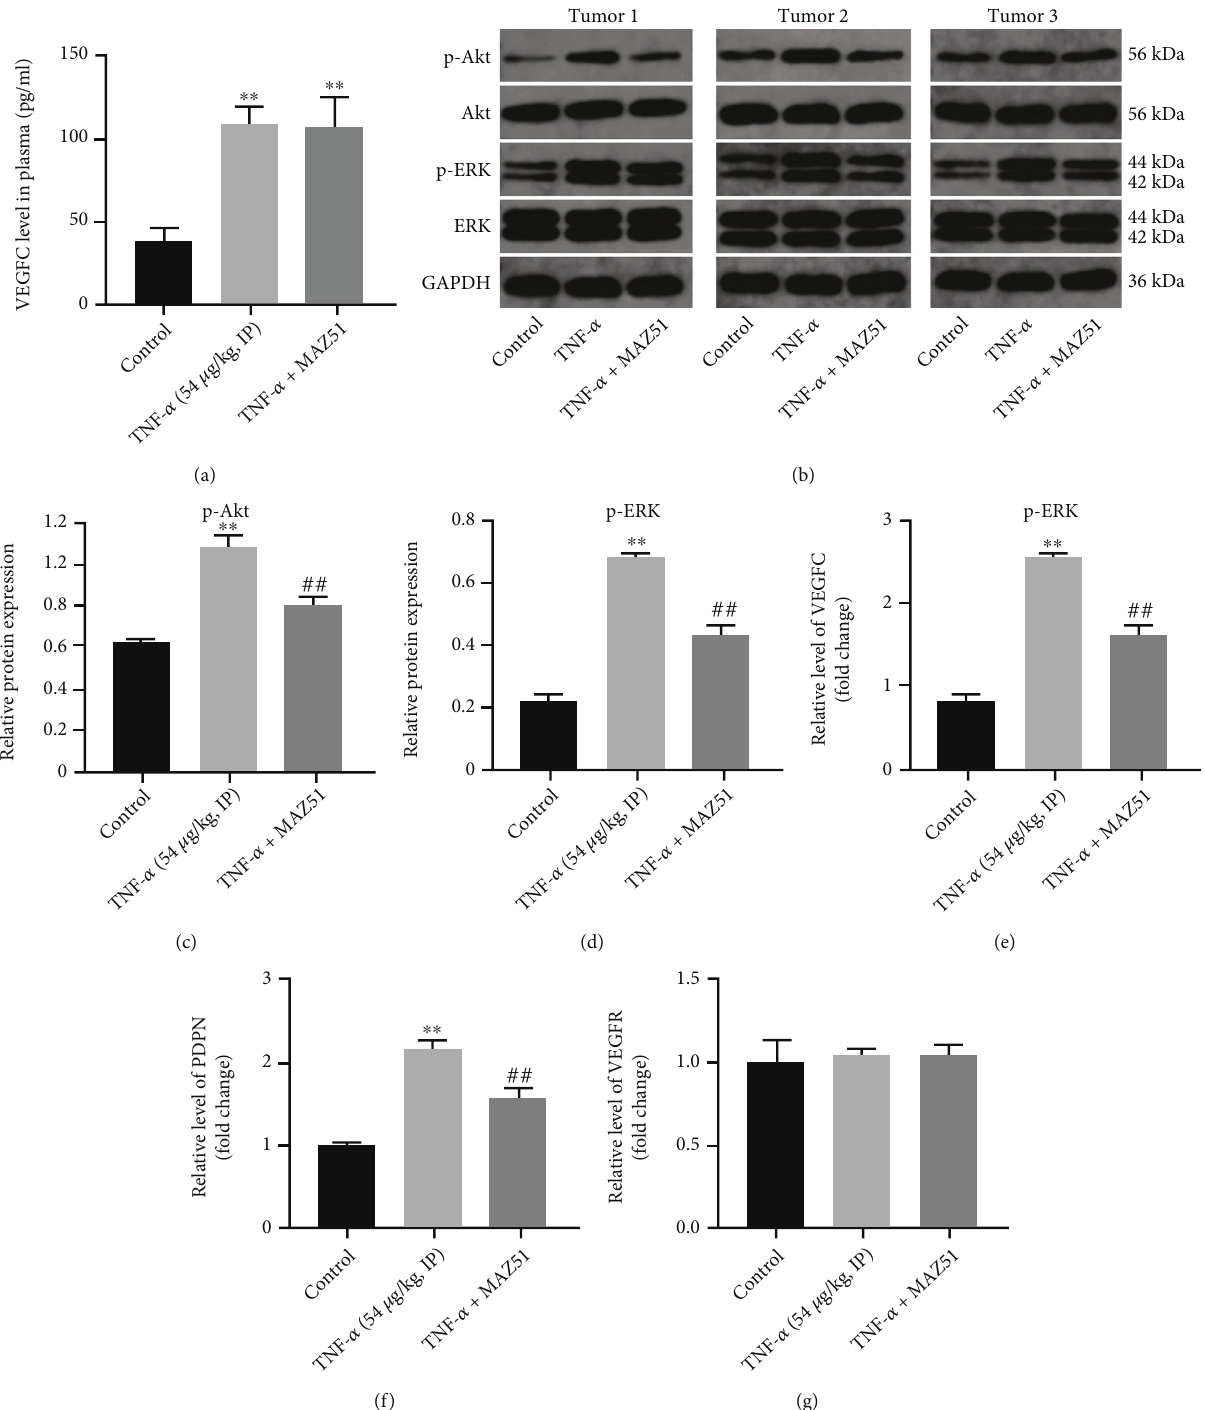
Figure 6: TNF- α upregulates p-AKT and p-ERK expression in tumor tissues via mediating VEGFC signaling in vivo . (a) The level of VEGFC in the plasma was measured by ELISA. (b – d) The levels of AKT, p-AKT, ERK, and p-ERK in tumor tissue were measured by western blot. (e – g) The levels of VEGFC, D2-40, and VEGFR were detected with RT-qPCR. ∗∗ P < 0 : 01 compared with control group; ## P < 0 : 01 compared with TNF- α treated group, n = 3